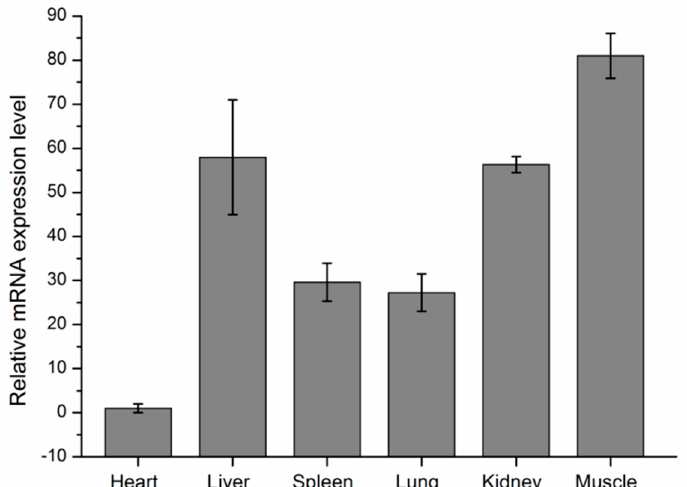
Figure 3. Expression profiling of KCNJ12 in different tissues of three 90-day-old fetuses. The values are the averages of three samples calculated by 2 −∆∆ Ct . Error bars represent the standard error (SE) ( n = 3) calculated by ∆ Ct. The GAPDH gene was chosen as the internal reference gene for the qPCR analysis.